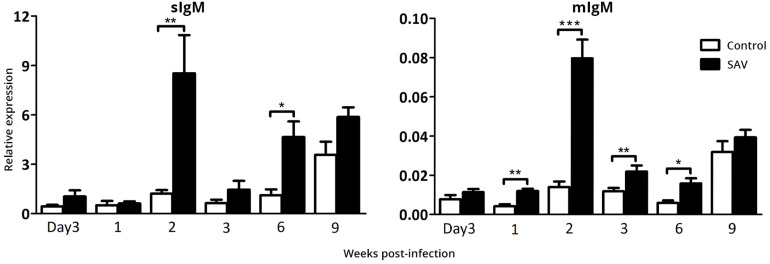
Biphasic expression of IgM transcripts in the heart from Atlantic salmon infected with SAV3. The expression of secreted (sIgM) and membrane (mIgM) IgM were determined by RT-qPCR in the heart from control and SAV3 infected fish and relative expression was calculated by the 2–ΔCt method. Data present mean + SEM from at least eight individuals (n = 8–10). Statistical significance between control and SAV3 groups is indicated by brackets. Asterisks indicate strength of significance.